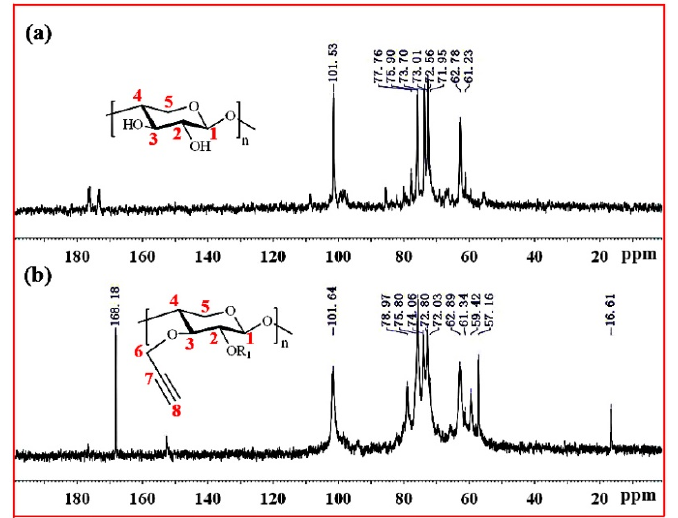
Figure 4. 13 C NMR spectra of ( a ) xylan and ( b ) Pg-xylan.